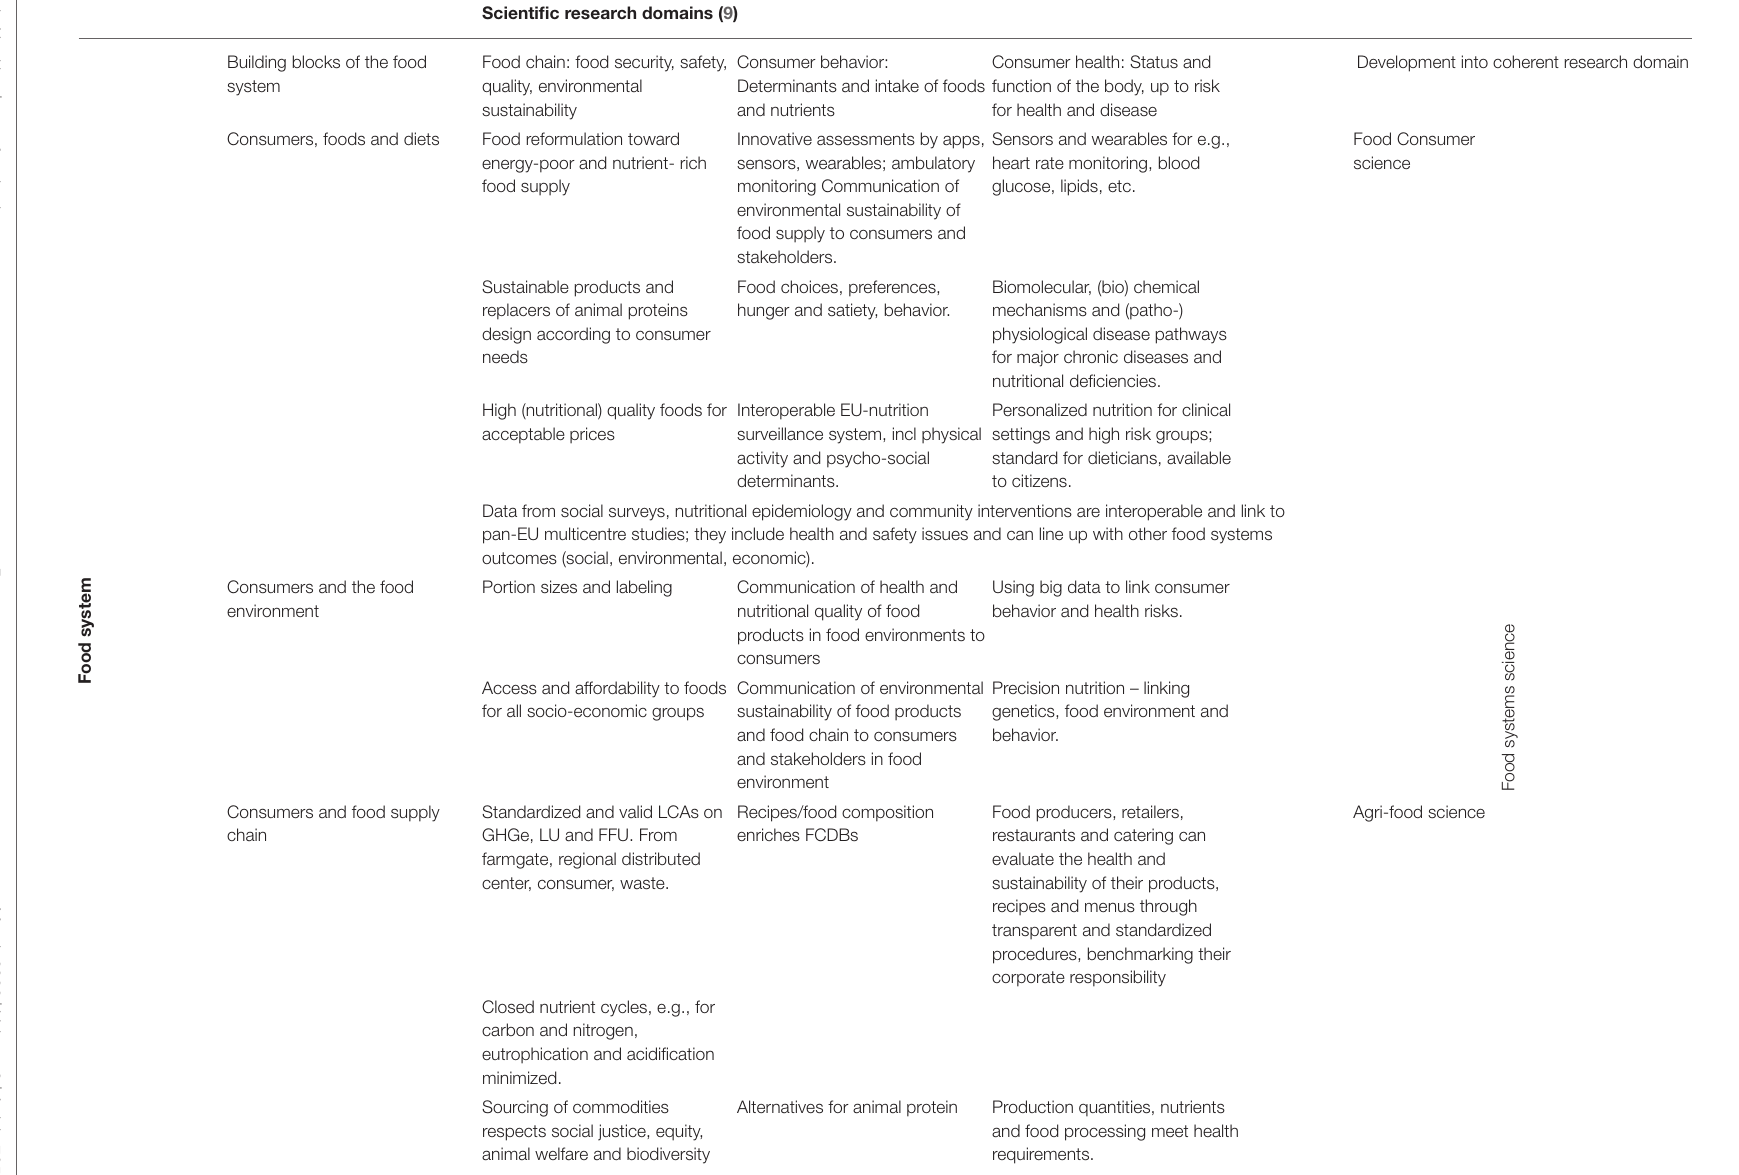
TABLE 1 | Examples of research and innovation domains of food nutrition and health research that can be supported by determinants and intake data platform. Scientific research domains